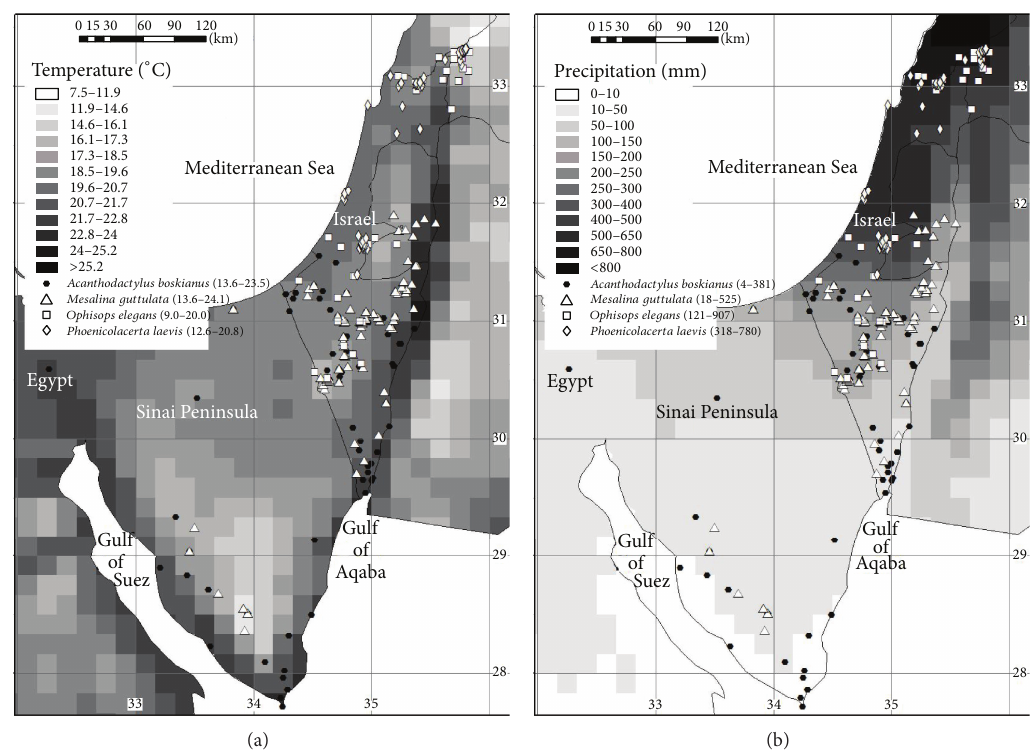
Figure 1: Climatic maps of the studied areas (excluding Turkish localities). (a) Average annual temperature and (b) average annual precipi- tation. The ranges of temperature and precipitation for each species are given in